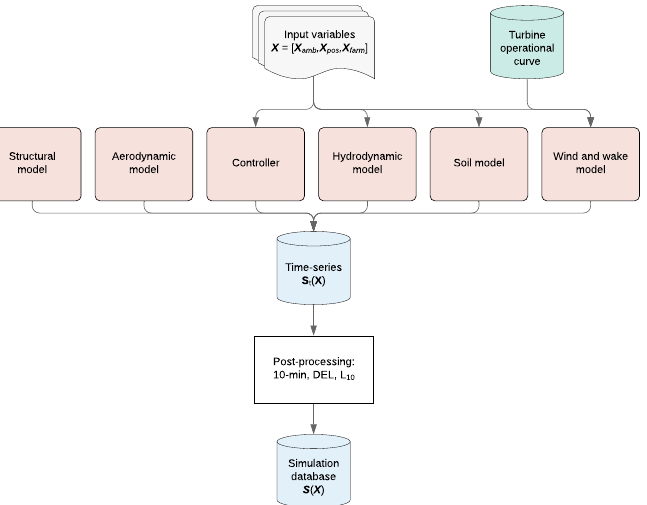
Figure 2. Process of aero-servo-hydro-elastic simulations using sampled input variables. The figure is taken from [15] which is distributed under CC BY 4.0 License. Details of the license are available at https://creativecommons.org/licenses/by/4.0/ (8 July 2021).